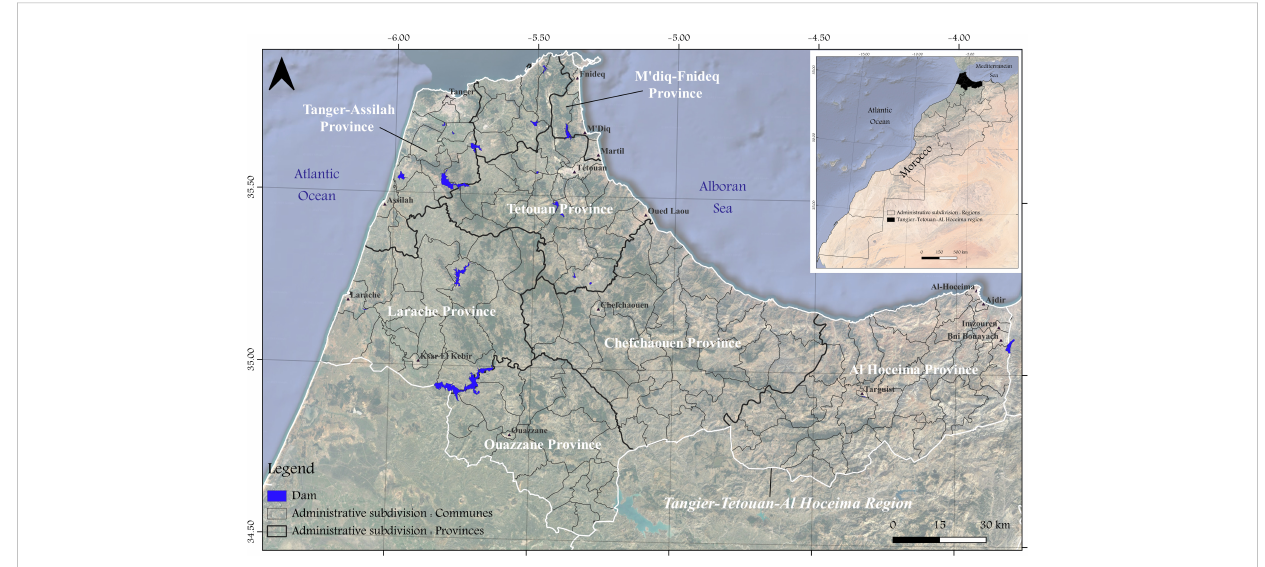
FIGURE 1 Geographical location of the TTA region and its administrative subdivisions. Background satellite imagery corresponds to google satellite of 2023, available as Basemap in QGIS v3.22.11